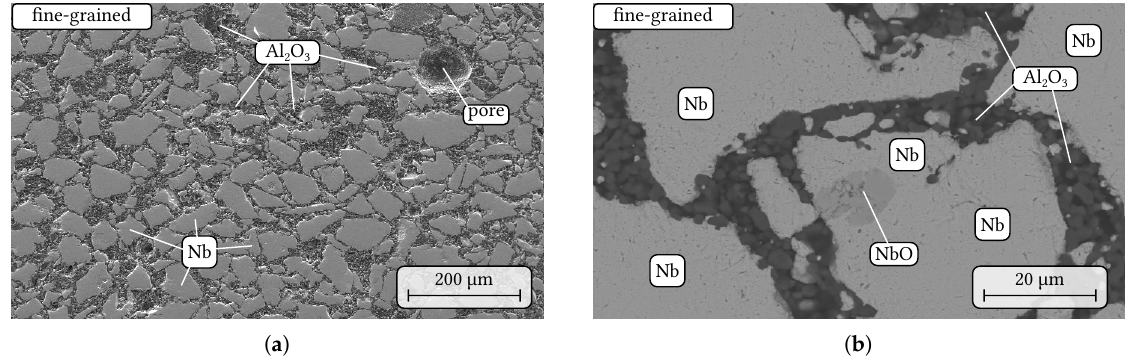
Figure 2. SEM micrographs of the fine-grained composite ( a ) SE contrast, overview and in detail ( b ) BSE contrast, NbO impurity within Nb grains surrounded by a finer grained alumina